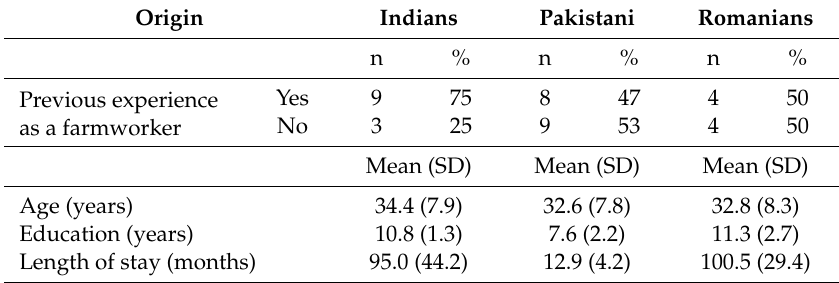
Table 2. Demographic characteristics of the migrant farmworkers participating in the